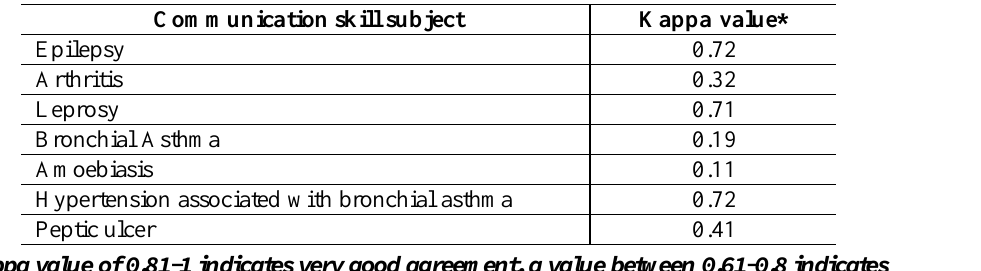
* A kappa value of 0.81-1 indicates very good agreement, a value between 0.61-0.8 indicates substantial agreement and 0.41-0.6 indicates moderate agreement. Values between 0.21-0.4 indicate fair agreement, values less than 0.2 indicates poor